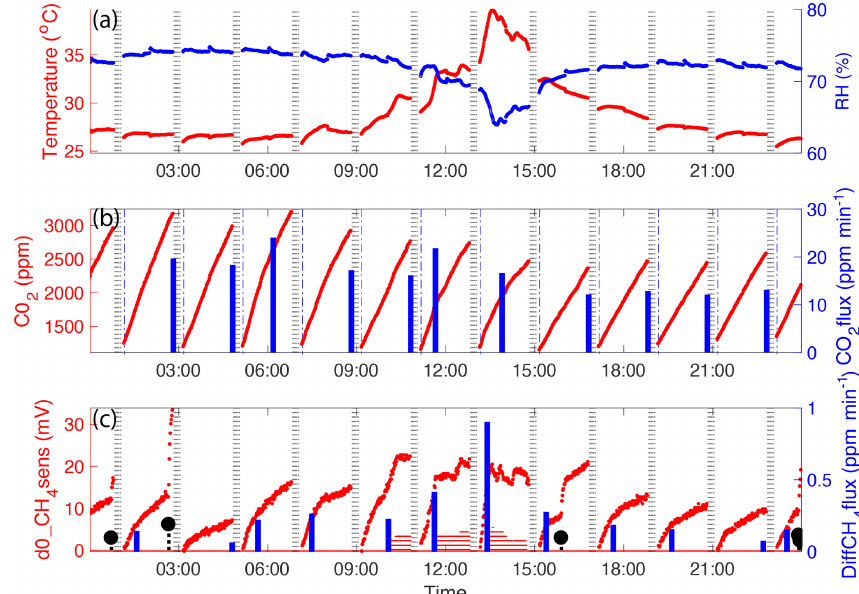
Figure 6. Example of 1 day of automatic flux chamber (AFC) measurements covering 11 accumulation periods. (a) Scatter plot of tempera- ture (left axis, red) and RH (right axis, blue) in the chamber. (b) Scatter plot of CO 2 concentration measured by an ELG CO 2 sensor (left axis) and bar plot of CO 2 fluxes calculated from slopes of the changing CO 2 concentration in the time range marked from the vertical dash–dot line to bar plot location (right axis). (c) Scatter plot of CH 4 sensor signal (left axis) and bar plot of CH 4 fluxes (right axis) calculated from the best linear data range when d0_CH 4 sens values were in the linear calibration range (less than 30mV). Temperature and RH changes are less than 2 ◦ C and 5%. Red shaded periods indicate sampling when temperature and RH affected the gas sensor response, and these data could therefore not be used in the flux calculation. In the event of an ebullition event, the flux calculation is made with data taken prior to that event. Ebullition events are marked by the black stem